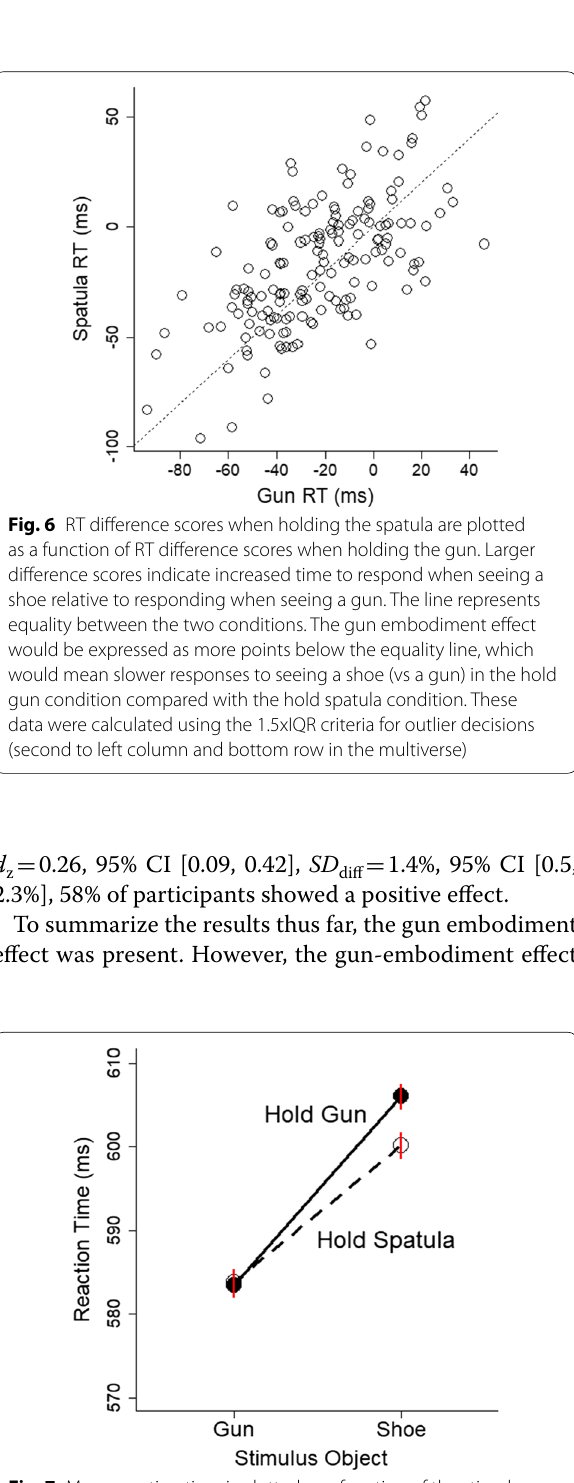
Fig. 5 B ″ scores when holding the spatula are plotted as a function of B ″ scores when holding the gun. Each point corresponds to one participant. Lower B ″ scores indicate more bias to respond that a gun is present. The line represents equality between the two conditions. The gun embodiment effect would be expressed as more points above the equality line, which would mean more bias to respond that